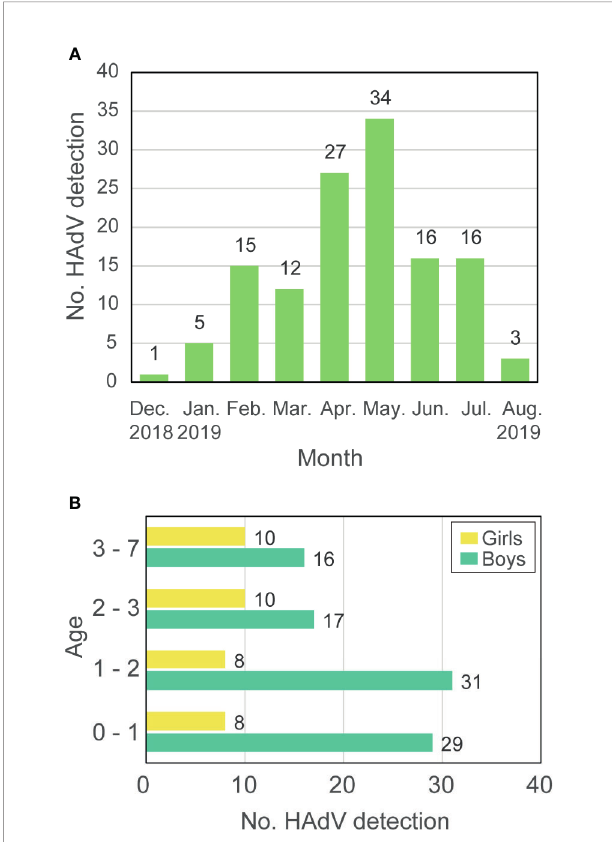
FIGURE 1 | Prevalence of HAdV-7 in Hubei during 2018-2019. (A) The number of HAdV detections. (B) Age and gender of patients. Labels around the bar represent the number of